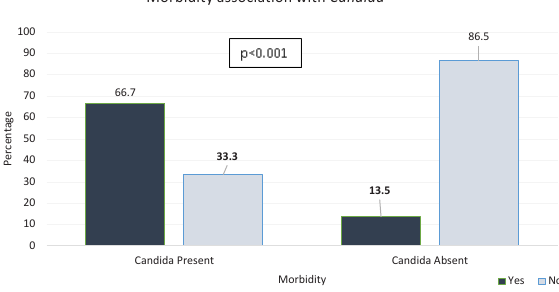
Figure 1. Morbidity associated with Candida peritonitis.